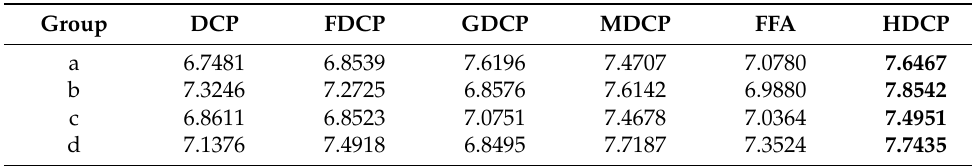
Table 4. Entropy of different